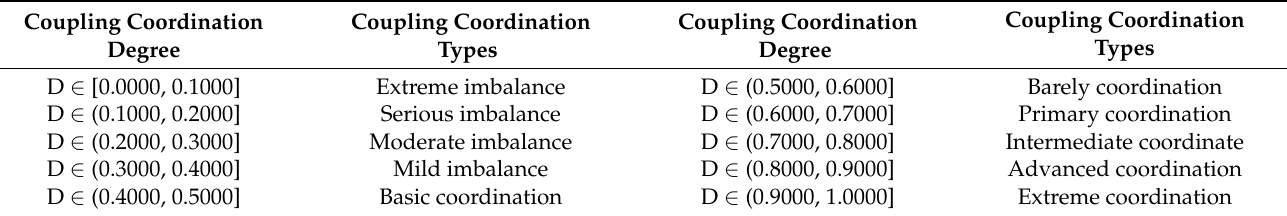
Table 1. The partition of coupling